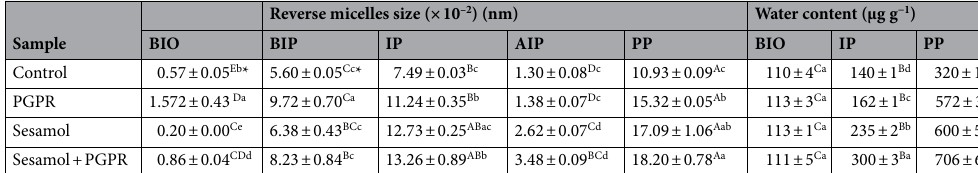
Table 2. Reverse micelles size and water content of sunflower oil samples. In each row and for each factor means with different uppercase letters are significantly different ( P < 0.05). In each column, means with different lowercase letter are significantly different ( P < 0.05). BIO at the beginning of the oxidation, IP at the induction period, AIP after the induction period, PP at the propagation period. *Mean ± SD (n = 3).